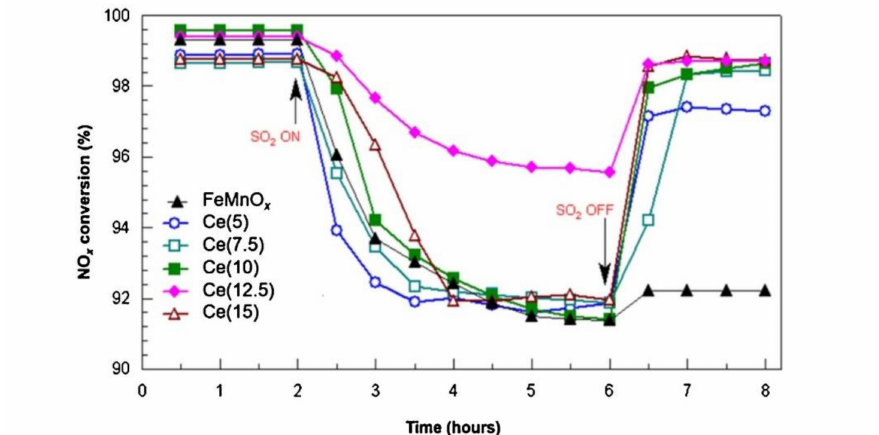
Figure 5. Influence of SO 2 on NO x conversion of FeMnO x and Ce(y) catalysts. Reaction conditions: [NO] = [NH 3 ] = 0.1%; [SO 2 ] = 100 ppm; [O 2 ] = 3%; N 2 balance, GHSV = 30,000 h − 1 ; reaction temperature = 120 ◦ C [15].